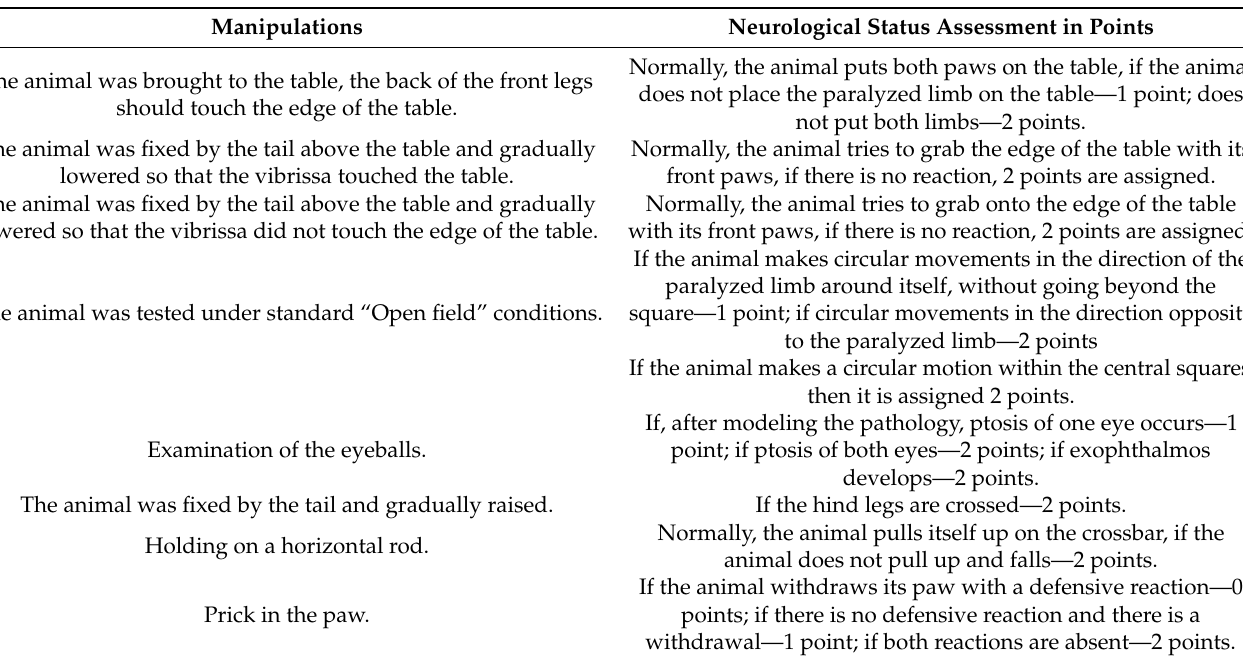
The animal was tested under standard “Open field”